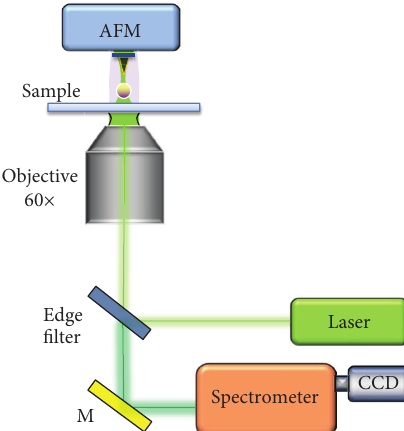
Figure 1: Schematic picture of our Raman set-up. Spontaneous RS or SERS measurements are made in backscattering con fi guration. In the upper part is mounted the AFM head for TERS